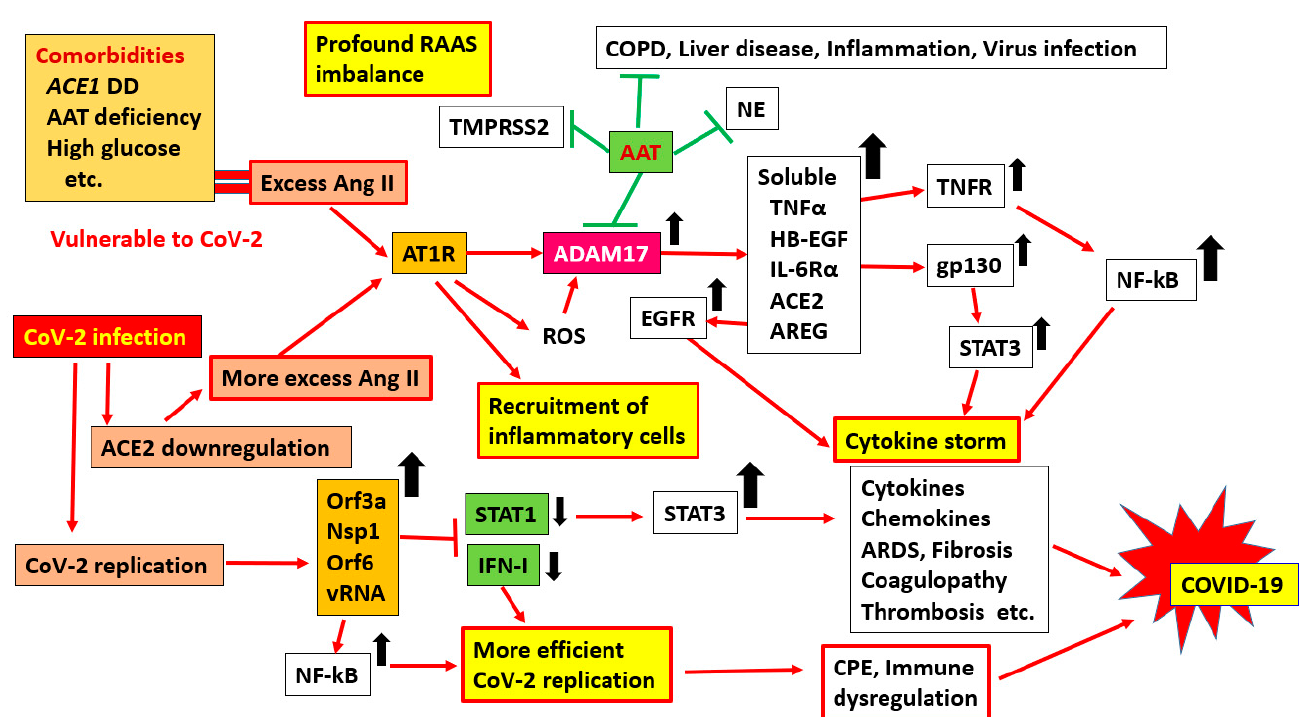
Figure 2. Possible steps leading to severe cases of COVID-19 among individuals with comorbidities after SARS-CoV-2 infection. Upon binding to receptors on target cells, such as epithelial cells and endothelial cells, SARS-CoV-2 induces ACE2 downregulation (endocytosis) along with the endocytosis of viral particles. As a result, Ang II is not subjected to ACE2-mediated degradation, and the ACE1/AT1R axis becomes more dominant. Additionally, it is well recognized that people with the ACE DD type show higher ACE1 activity in serum [21]. Thus, when ACE2 deficiency due to SARS-CoV-2 infection occurs, excessive Ang II stimulation will further amplify the RAAS imbalance. Stimulation by Ang II induces the activation of PKC and causes the production of reactive oxygen species and the activation of ADAM17, a pleiotropic enzyme. When ADAM17 is activated, many membrane proteins, such as TNF- α , HB-EGF, IL-6R α , ACE2, and amphiregulin (AREG), are cleaved. As a result, the activation of proinflammatory substances (IL-6, STAT3, EGFR, TNF- α , and neutrophil elastase) leads to a cytokine storm [22–24]. These data support the hypothesis that the RAAS is a major mediator of inflammation. On the other hand, several SARS-CoV proteins have been shown to inhibit multiple arms of type I IFN responses and significantly suppress IFN- β production during infection. Utilizing these strategies, SARS-CoV-2 may replicate more efficiently in infected individuals. AAT suppresses SARS-CoV-2 infection through the inhibition of TMPRSS2 and ADAM17 protease. AAT-mediated ADAM17 inhibition can also regulate ACE2 cleavage and protect lung and heart tissue from the harmful effects of RAAS imbalance. In addition, AAT inhibits ADAM17, resulting in the inhibition of TNF- α and IL6-R cleavage, which can exert anti-inflammatory effects. In addition, AAT is involved in the control of neutrophil chemotaxis and the suppression of neutrophil elastase (NE). An upward and a downwards black arrows indicate an increase and a decrease in protein, respectively.